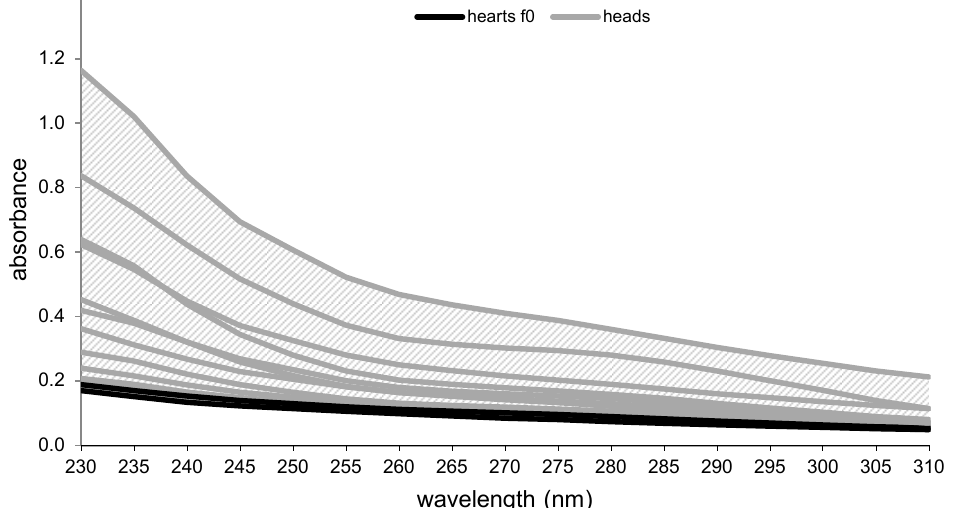
Figure 4. Absorbance spectra of 100 mL subfractions of heads (grey) and first hearts fraction f0 (black). Each line indicates the average spectrum. Standard deviation ≤ 0.01. Table 4. Area-under-the-product absorbance curve and zero-point values of the calculated inte- grals. Integrals were evaluated via the according exponential function of heads and hearts subfrac- tion spectra ( n = 3) with a lower bound of 230 and an upper bound of 310.